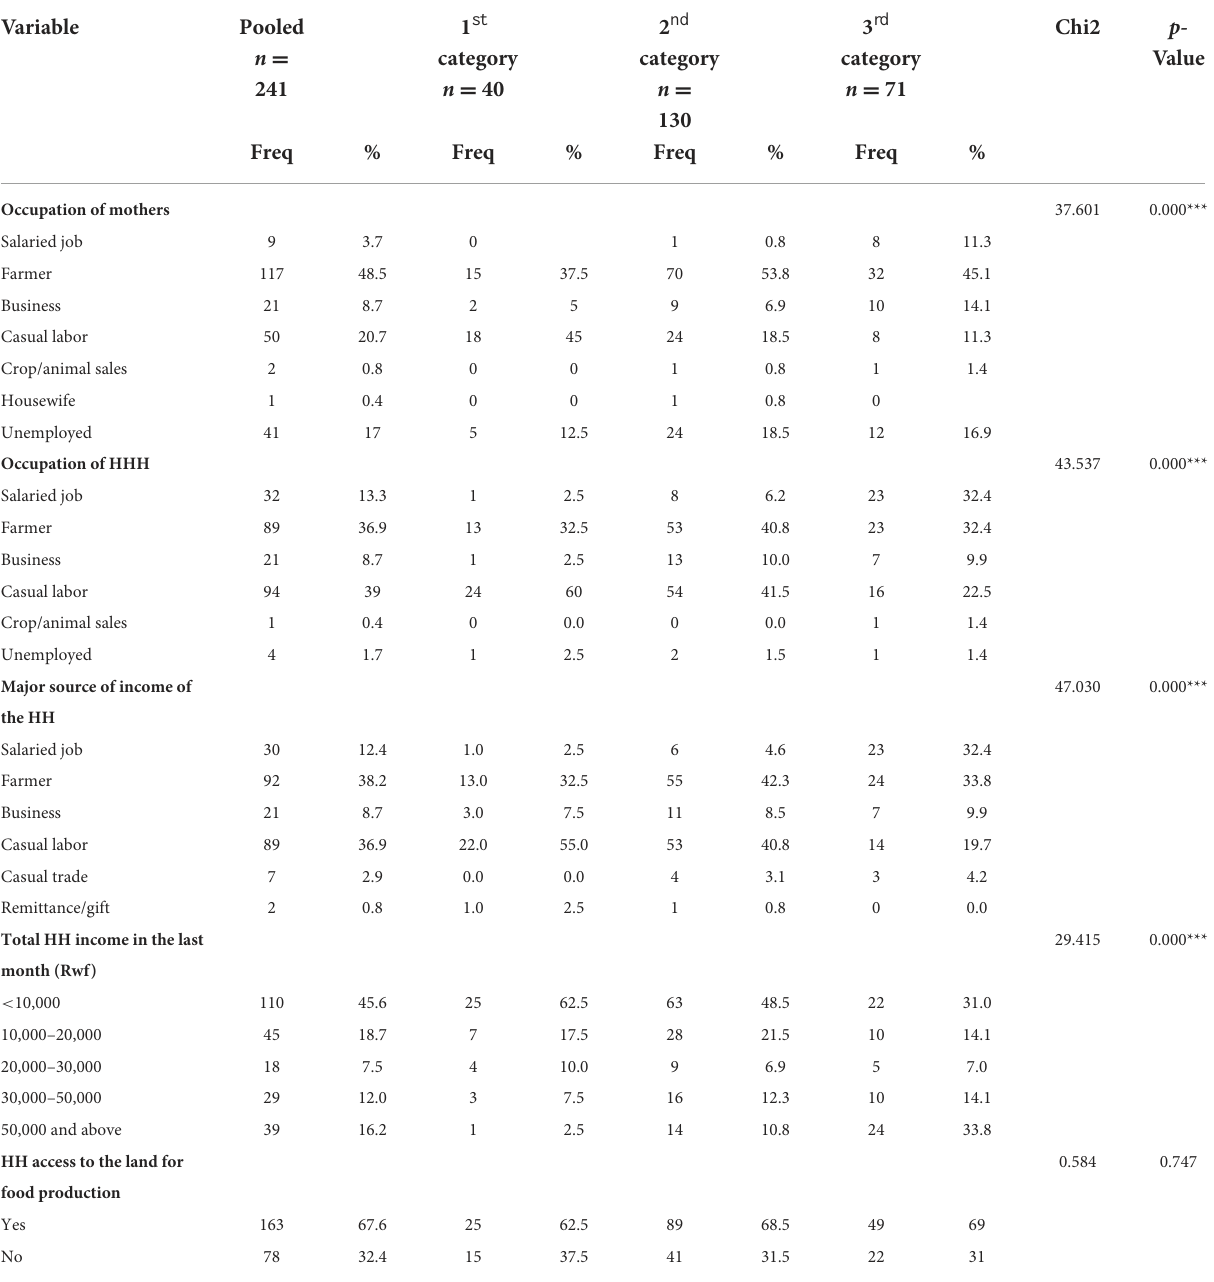
TABLE 2 Socio-economic characteristics of household members across their wealth categories.